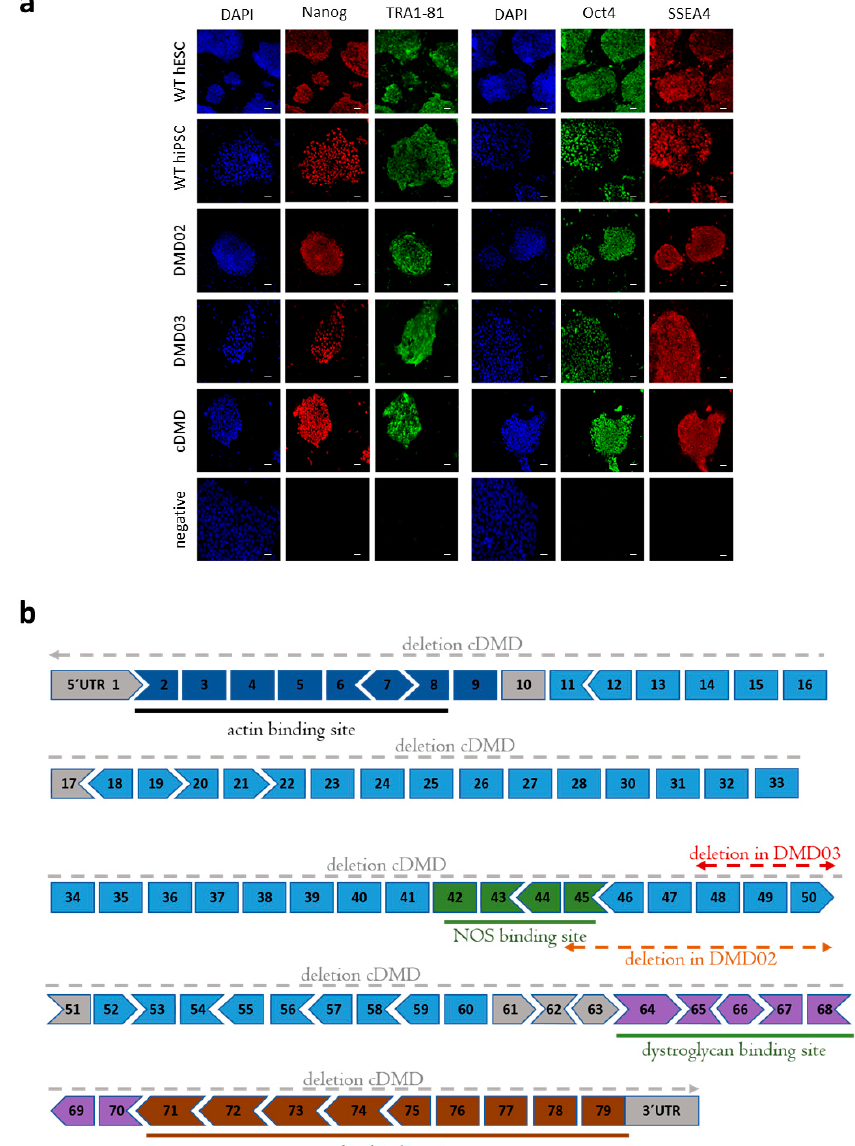
Figure 1. DMD hPSC lines are pluripotent. ( a ) Two patients derived (DMD02 and DMD03) and hESC derived (cDMD) DMD stem cell lines were analyzed for presence of pluripotency markers (Nanog (red on the left), TRA1-81 (green on the left) with their corresponding DAPI staining, and Oct4 (green on the right), SSEA4 (red on the right) with their corresponding DAPI staining). All DMD hiPSC and cDMD lines present comparable expression to WT (WT hESC and WT hiPSC). Nuclei are counterstained with DAPI (blue). Ruler represents 50 µ m. ( b ) Structure of the DMD gene and positions of mutations in each DMD hPSC line. Locations of binding sites for actin, NOS, dystroglycans and syntrophins are shown. The diagram shows how the 79 exons fit together in terms of the normal open reading frame. Exons are colored according to the domain they encode: N-terminus (dark blue), rod domain (light blue dark green with hinge regions in grey), cysteine-rich domain (purple) and C-terminus (brown). NOS binding site is visualized in green. DMD02 line carries deletion of exons 45–50 (red line), DMD03 deletion of exons 48–50 (orange line) and cDMD lacks a whole allele and all exons are deleted from the chromosome (grey